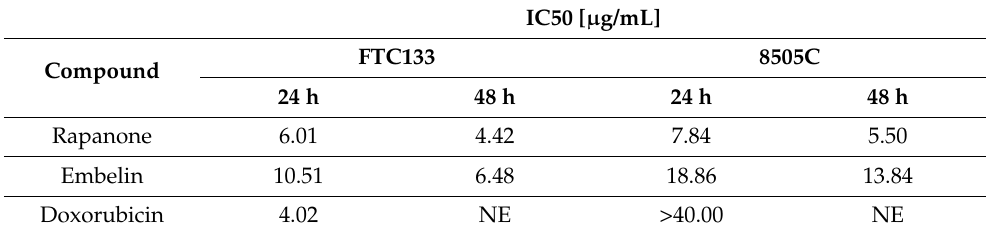
Table 5. IC 50 values of rapanone, embelin, and doxorubicin in thyroid cancer panel.